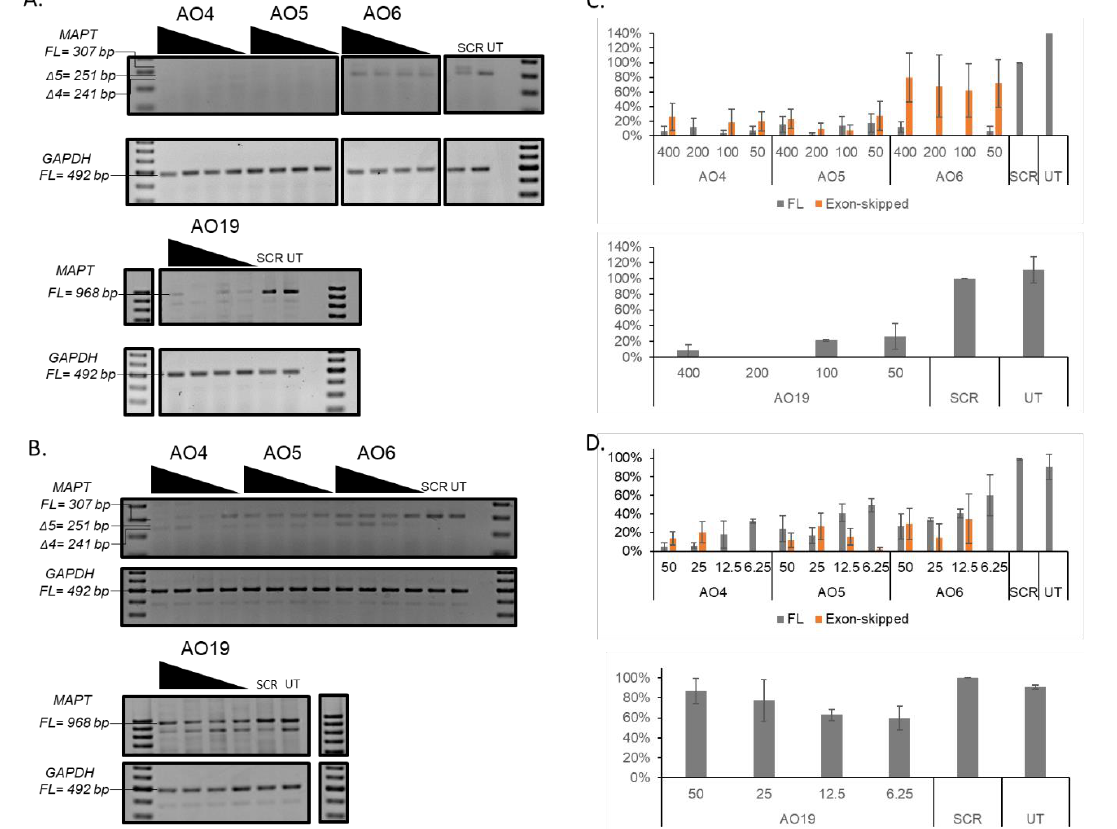
Figure 4. ( A ) Representative RT-PCR products of the MAPT and GAPDH transcripts from SH-SY5Y cells after treatment with AO4, AO5, AO6, and AO19 at 400, 200, 100, and 50 nM